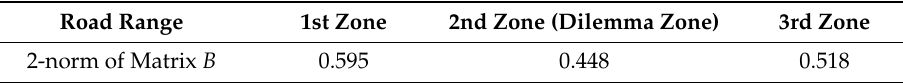
Table 5. 2-norm of matrix B of different zones of the intersection approaching